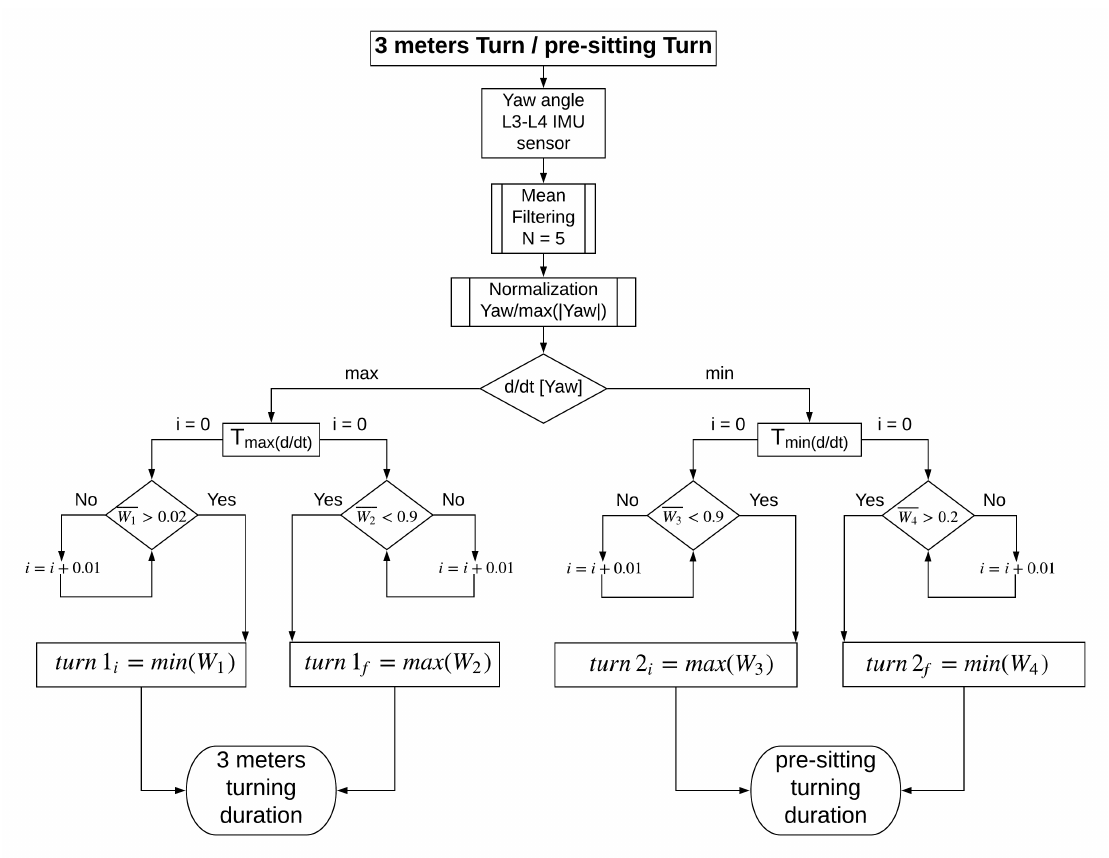
Figure 11. Automatic feature-based segmentation algorithm for the turning actions in the 3-m TU & Go